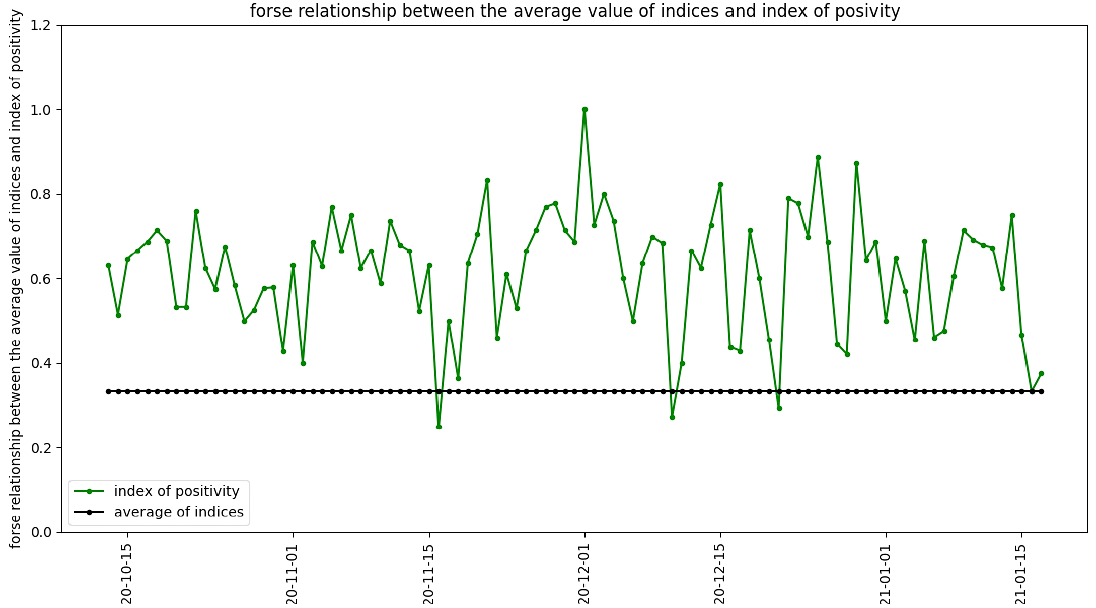
Figure 3. Average indices and positivity